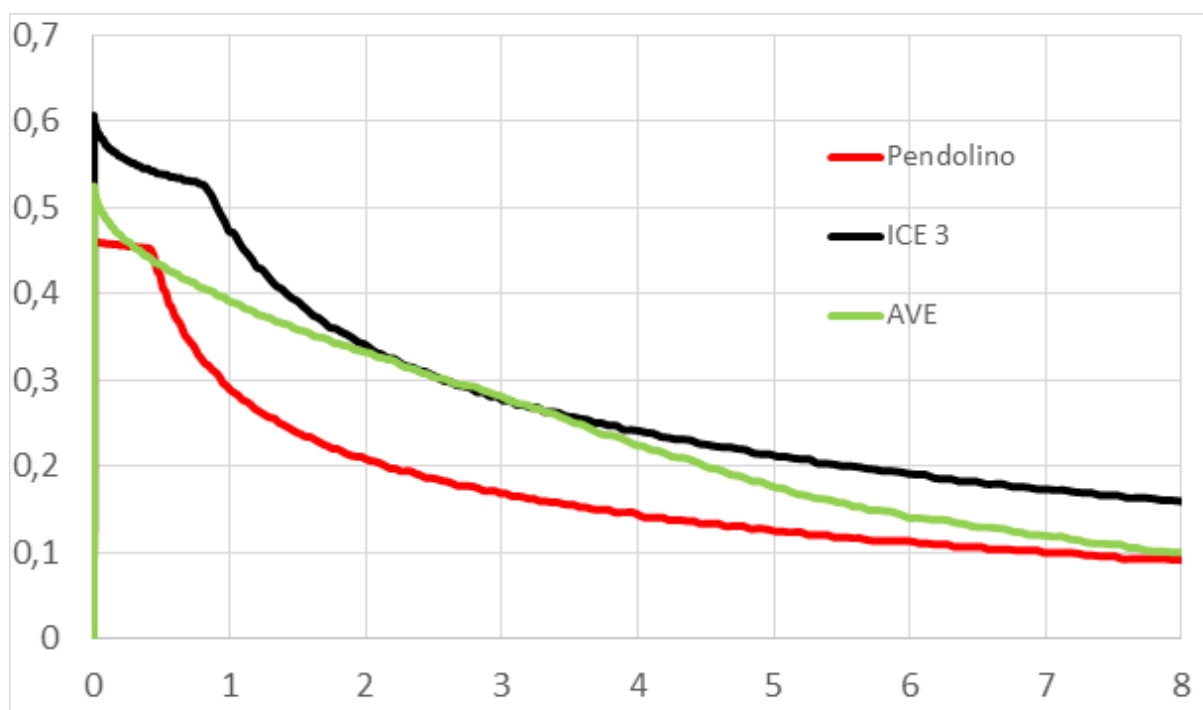
Figure 3. Acceleration of units [m · s − 2 ], source: